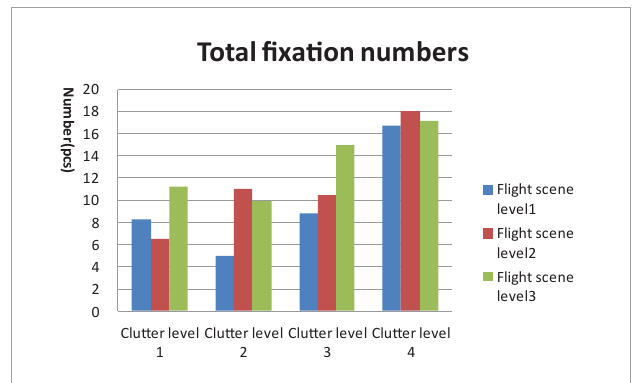
FIGURE5 General linear model (GLM) Univariate test of total fixation